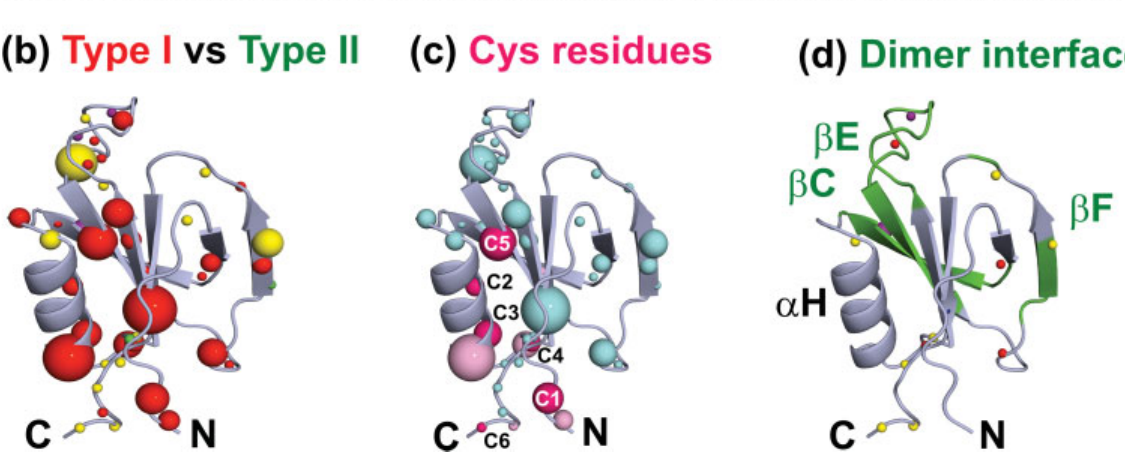
Fig. 6 Mutational residue frequency in terms of a consensus Ap domain. A consensus Ap domain of length 87 residues shows the distribution of 90 Ap variants (missense and polymorphisms) in the four Ap1-Ap4 domains merged together. (a) The four Ap domain sequences are aligned to form a consensus, with the averaged secondary structure (Sec) and accessibility (Acc) of each residue listed directly below. The ‘ Tot ’ row illustrates the total number of variants found at each residue in the consensus. The six conserved Cys residues in each domain are highlighted in black and numbered 1 – 6 underneath the alignment. The Cys-Cys bridges occur at Ap1 (Cys20-Cys103, Cys46-Cys76, Cys50-Cys56), Ap2 (Cys110- Cys193, Cys136-Cys165, Cys140-Cys146), Ap3 (Cys200-Cys283, Cys226-Cys255, Cys230-Cys236) and Ap4 (Cys291-Cys374, Cys317-Cys346, Cys321-Cys327). Type I variants are circled in red, Type II in green and those of unknown phenotype in orange. Non-disease associated polymorphisms are circled in purple. The green residues in Ap4 mark those present at the FXI dimer interface. The ‘ Sec ’ rows highlight the α -helix region (H) and the fi ve β -strand regions (E) in the consensus Ap domain. The β -strand regions are denoted AB, C, D, E and FG. The ‘ Acc ’ row denotes the relative accessibility of each consensus residue, where accessibilities of 0 or 1 indicate buried sidechains and accessibilities > 1 indicate sidechain exposure to solvent. (b) Variants are colored according to phenotype. Type I variants are colored in red, Type II in green and those of unknown phenotype in yellow. Polymorphisms are shown in purple. The sphere color represents the most commonly occurring phenotype at that position according to the sequence alignment in (a). The size of the spheres indicates the number of variants found at that position, and ranges from one to fi ve. N and C refer to the N- and C-termini respectively. (c) Cys variants and their neighboring residues are shown as dark and light pink spheres respectively. All other variants are depicted in blue. The size of the spheres is again indicative of the number of variants found at that position. The six Cys residues are labeled C1-C6. ( d ) The FXI dimer interface is highlighted in green and the β -strands present at the interface are labeled. Variants found within Ap4 are shown as spheres, colored according to their phenotype as in (b).